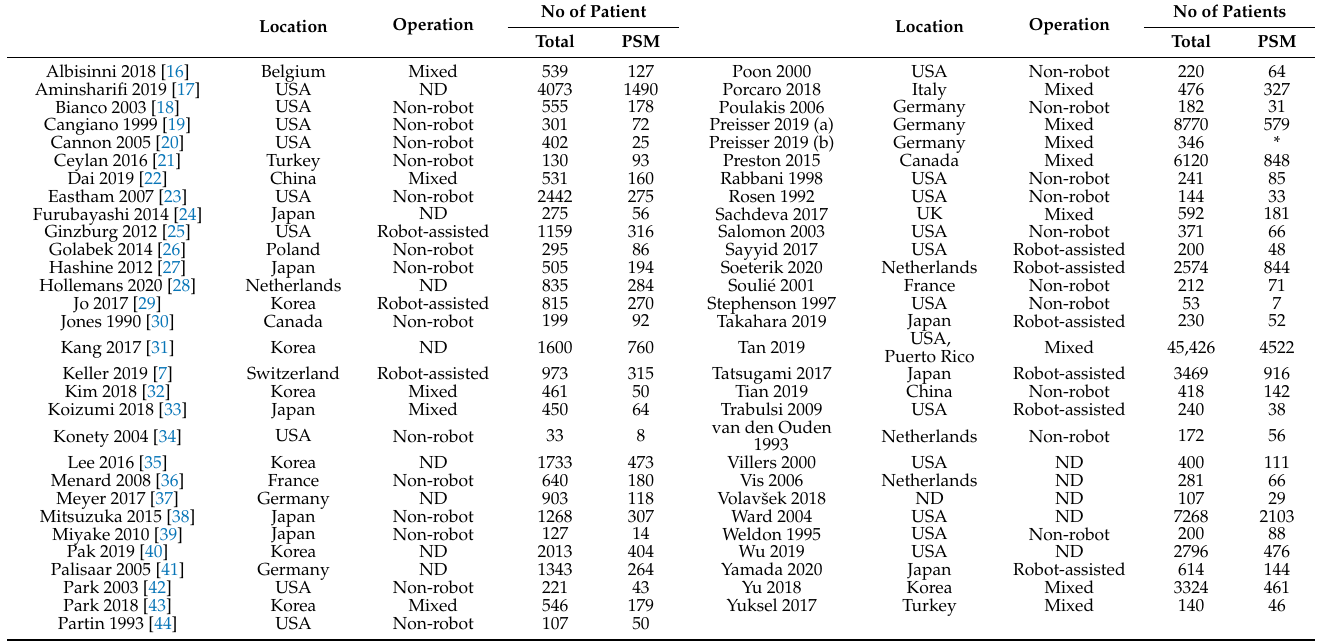
Table 1. Main characteristics of the eligible studies.